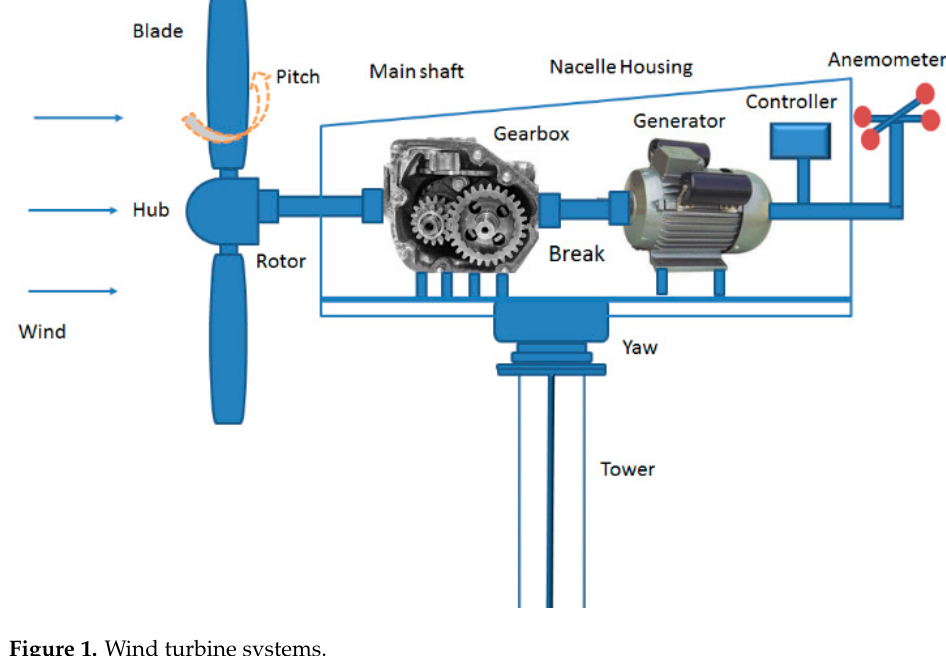
Figure 1. Wind turbine systems.